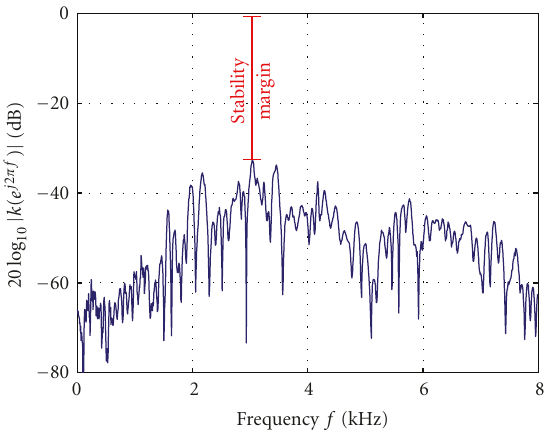
Figure 4: Illustration of the stability